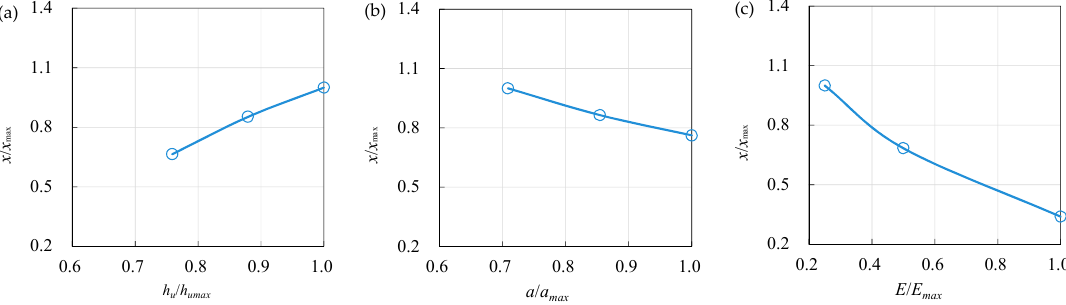
Figure 13. Variation of displacement at the top of the structure with di ff erent parameters: ( a ) the height of the water column; ( b ) the distance between the water column and the structure; and ( c ) the Young’s